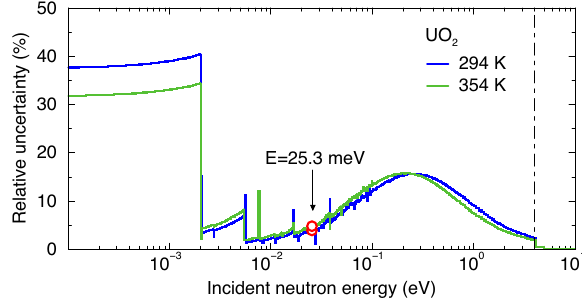
Fig. 11. Relative uncertainty calculated on the elastic scatter- ing cross sections of UO 2 . The dotted black line indicates the thermal cut-off energy (4